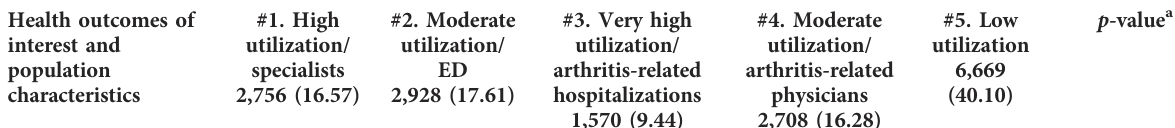
TABLE 4 Health outcomes of interest according to CareT group